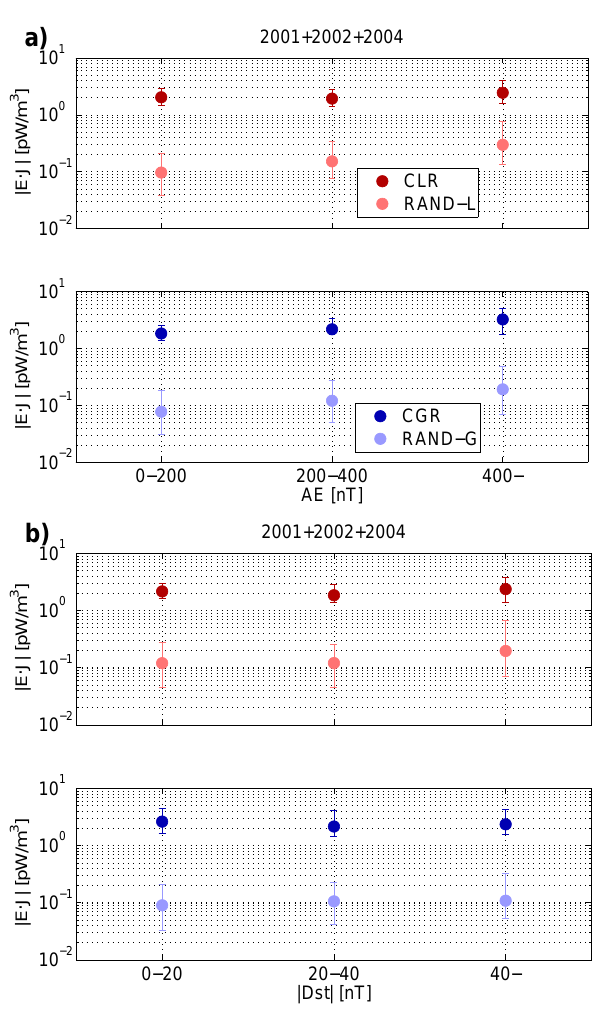
Fig. 6. The strength of the plasma sheet energy conversion as a function of AE (a) and Dst (b) . Similar to Fig. 5, the energy con- version strength is expressed as the median of the magnitude of the average power density. The error bars indicate the 25% and 75% percentiles. Red and light red correspond to CLRs and RAND- Ls, while blue and light blue correspond to CGRs and RAND-Gs. The AE and Dst binnings are the same as in Figs. 3 and 4, respec- tively. Only data from the combined data base 2001+2002+2004 are shown.